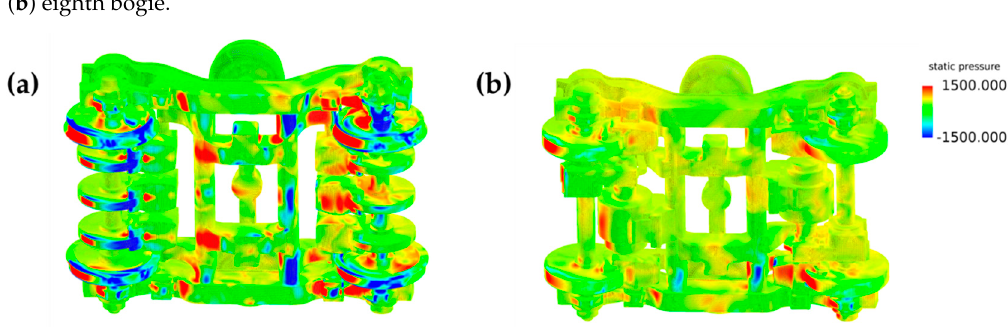
Figure 10. Instantaneous surface pressure contours: ( a ) first bogie; ( b ) eighth bogie.